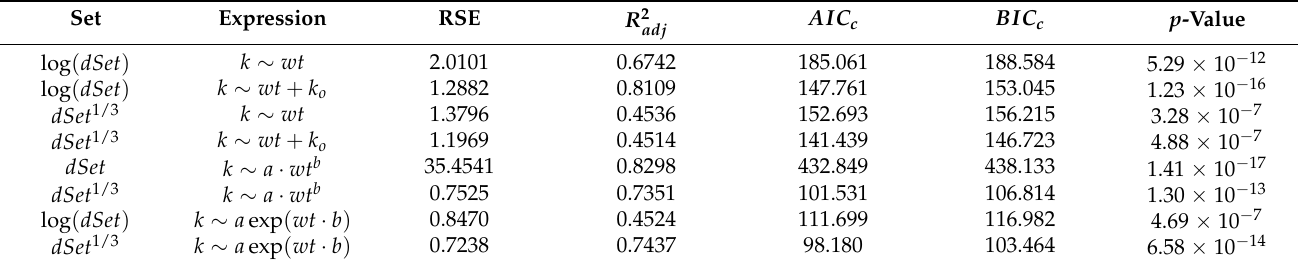
Table 10. Regression results for k vs. wt for the XG